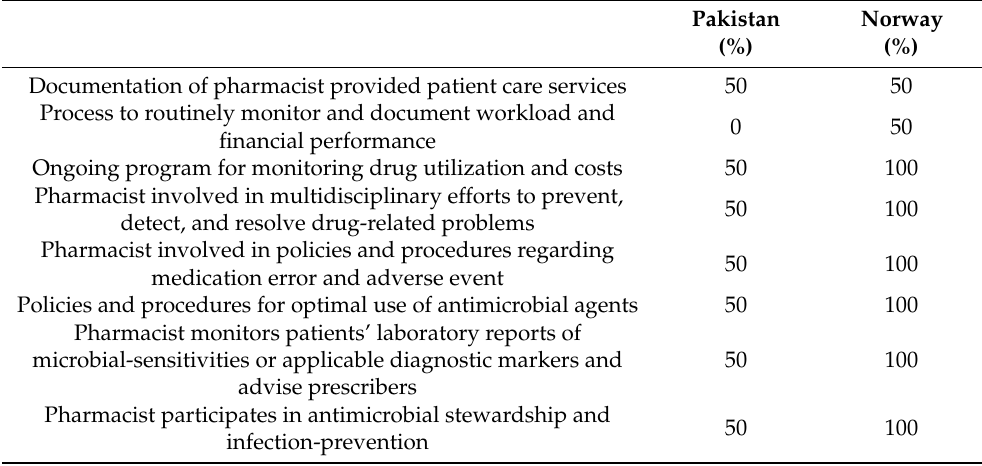
Table 10. Pharmacists’ assessments on evaluating the effectiveness of the medication-use